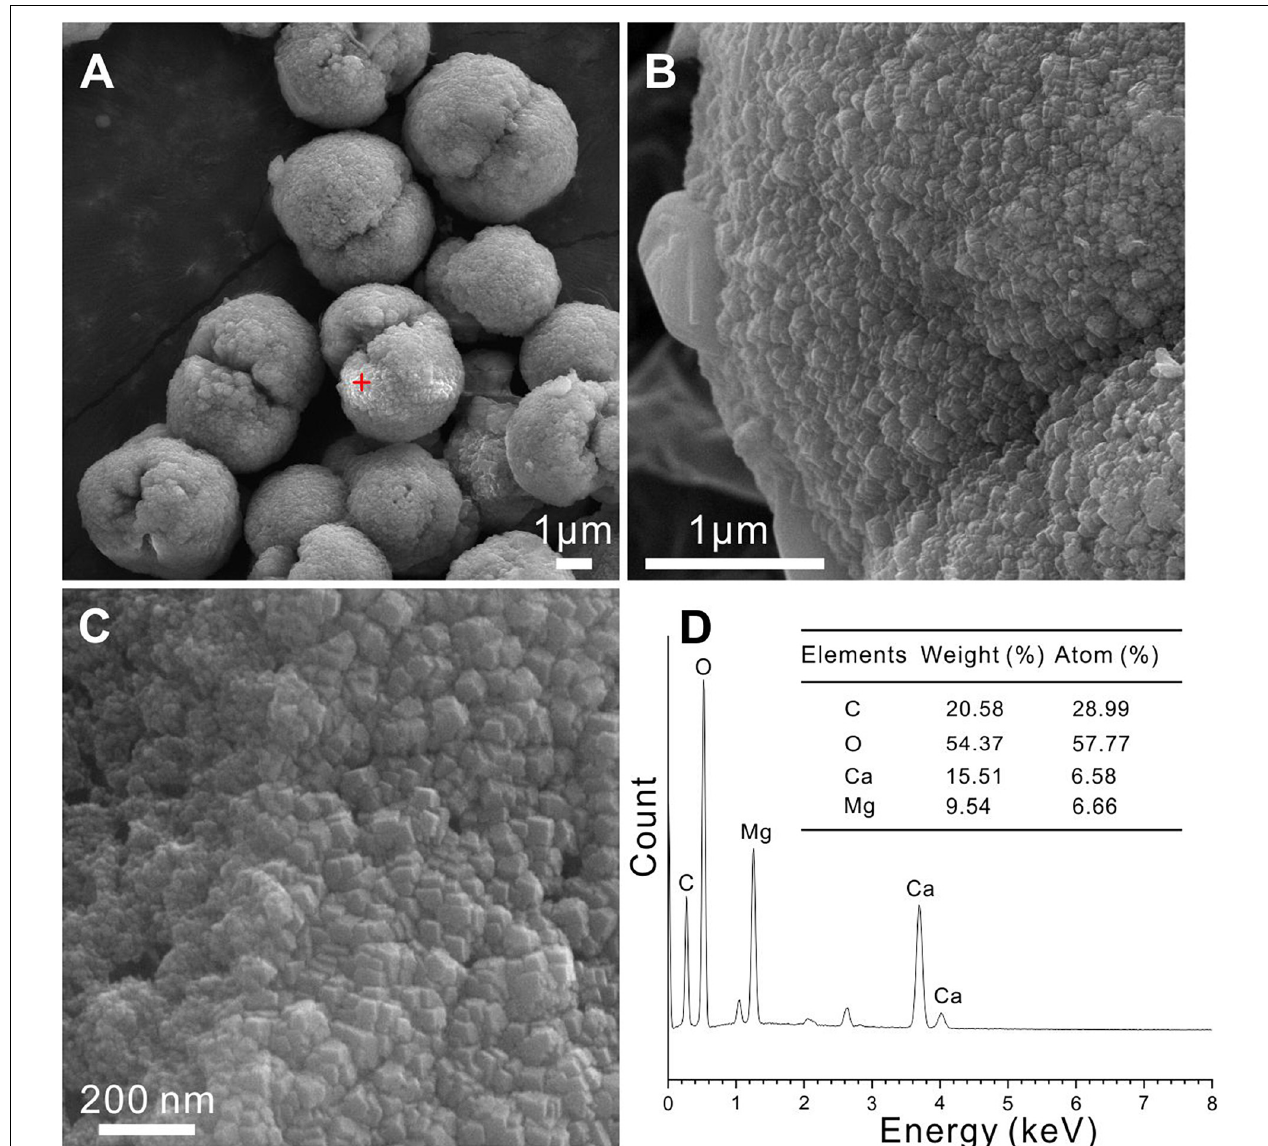
FIGURE 7 | Protodolomite synthesized in a purely inorganic solution at 60 ◦ C. (A–C) The morphology and surface patterns of the abiotic protodolomite. (D) EDS analysis of the selected spot in panel (A)